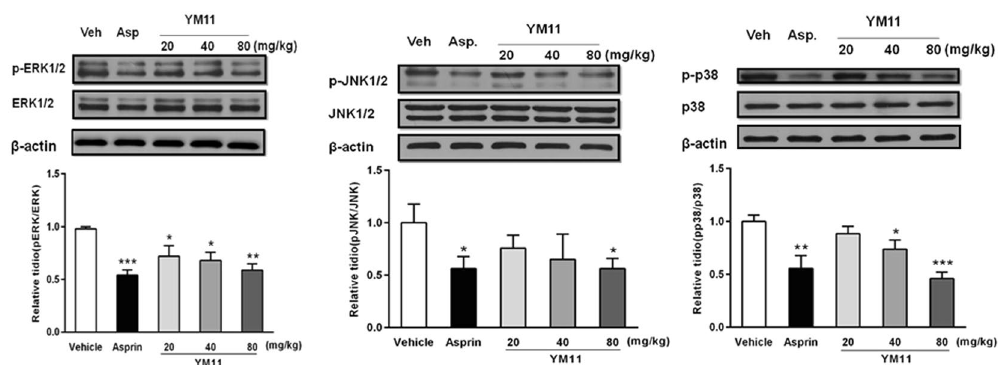
Figure 12. Changes of MAPKs protein expression in L 4–6 DRGs among groups. The representative bands for the expressions of p-ERK, p-JNK and p-p38 in DRG after injection of formalin. The quantitative data for the expression of each phospho-MAPKs. The fold change for the density of each phospho-MAPKs normalized to total MAPKs for each sample. The fold change of phospho-MAPKs levels in vehicle group was set at 1 for quantifications. Data were shown as mean ± SEM. * P < 0.05, ** P < 0.01, *** P < 0.001 vs .